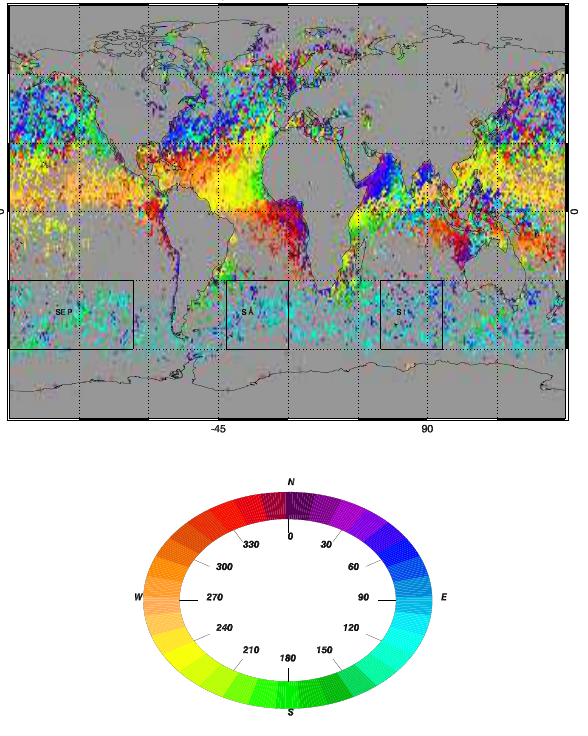
Fig. 4. Plot of wind direction θ max for the locations where σ τ is greater than 0.035. Rectangles indicate the three regions in which the dependance of AOD on wind speed has been examined.